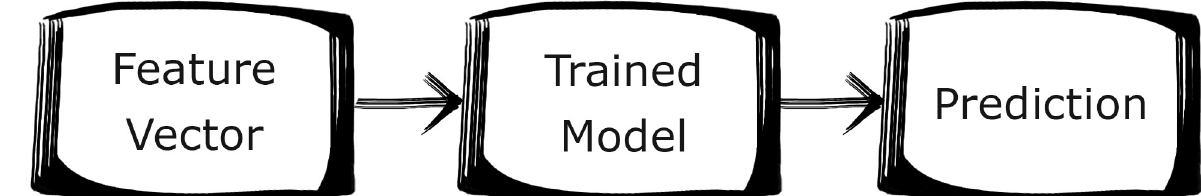
Fig 2. The ANN-based model used to make prediction from the set of independent variables, called the feature